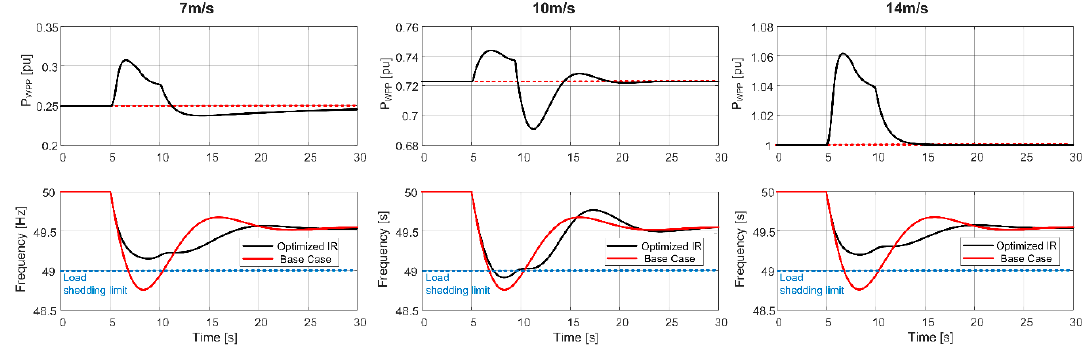
Figure 6. Active power outputs and improved system frequency responses of WPPs with optimized parameters given in Table 2 for 7 m/s, 10 m/s, and 14 m/s wind speeds.